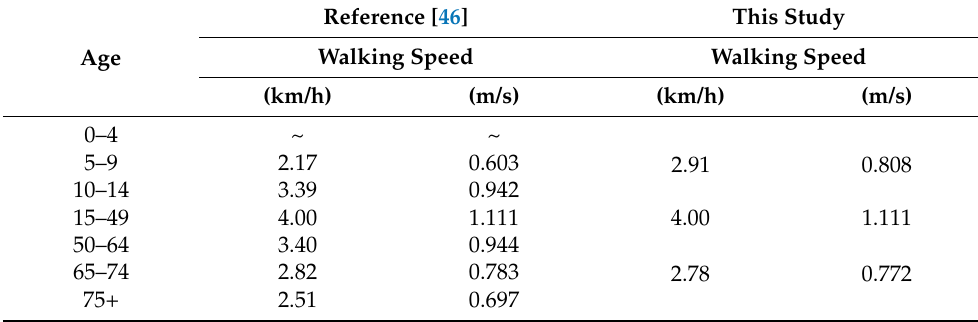
Table 3. Agent walking speeds considered in the simulation.